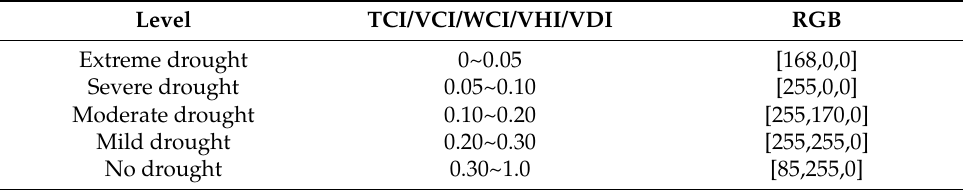
Table 2. Drought severity criteria for the TCI, VCI, WCI, VHI, and